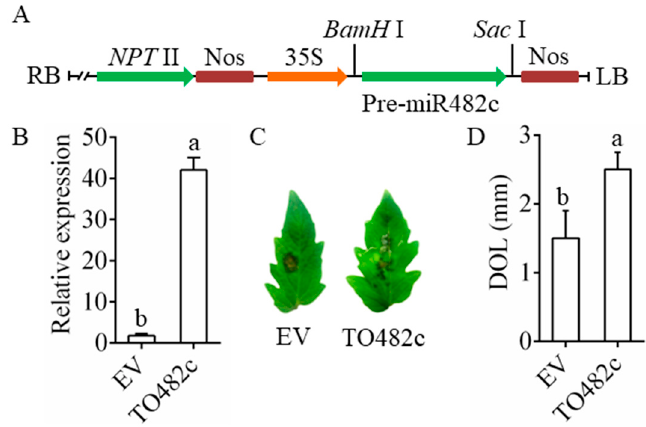
Figure 2. Transient overexpression of miR482c in tomato leaves. ( A ) The framework of the miR482c-overexpression vectors. ( B ) The expression level of miR482c in tomato that transiently overexpressed miR482c. EV: empty vector; TO482c: transiently overexpressing pBI121-miR482c. ( C ) The necrotic lesions on the leaves of EV and TO482c plants on the 3rd day after inoculation. ( D ) The diameters of necrotic lesions (DOL) in EV and TO482c plants. SDs of three replicates are indicated with error bars. The letters above the column indicate a significant di ff erence ( p < 0.05) between the